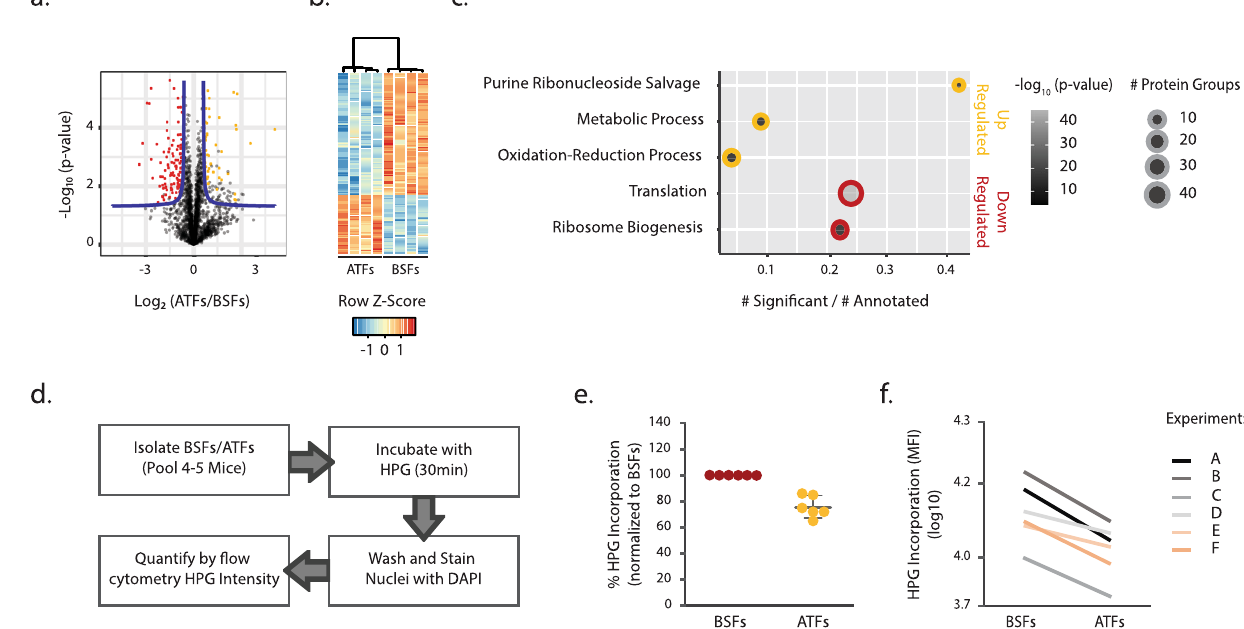
Fig. 3 | Proteome analysis and protein synthesis of parasites isolated from blood and gonadal adipose tissue. a Representative Volcano plot of 1 out of the 1000 performed imputations with the 2693 protein groups detected by mass spectrometryinthesumofBSFsandATFs8datasets.Redandyellowdotsindicate protein groups signi fi cantly upregulated in BSFs and ATFs, respectively. Proteins were obtained from Lister 427 parasites isolated from a pool of 5 – 6 animals infectedfor5days( n =4independentexperiments). b Heatmaprepresentingthe z - score abundances of the differentially expressed protein groups. Each column corresponds to one independent pool of mice. c Enriched GO terms (Biological Process) of the differentially upregulated (yellow circles) and downregulated (red circles) proteins according to gene ratio, using a False Discovery Rate corrected p - valuecut-offof0.05(two-sidedFisher ’ sexacttest).Eachdotcorrespondstoagiven